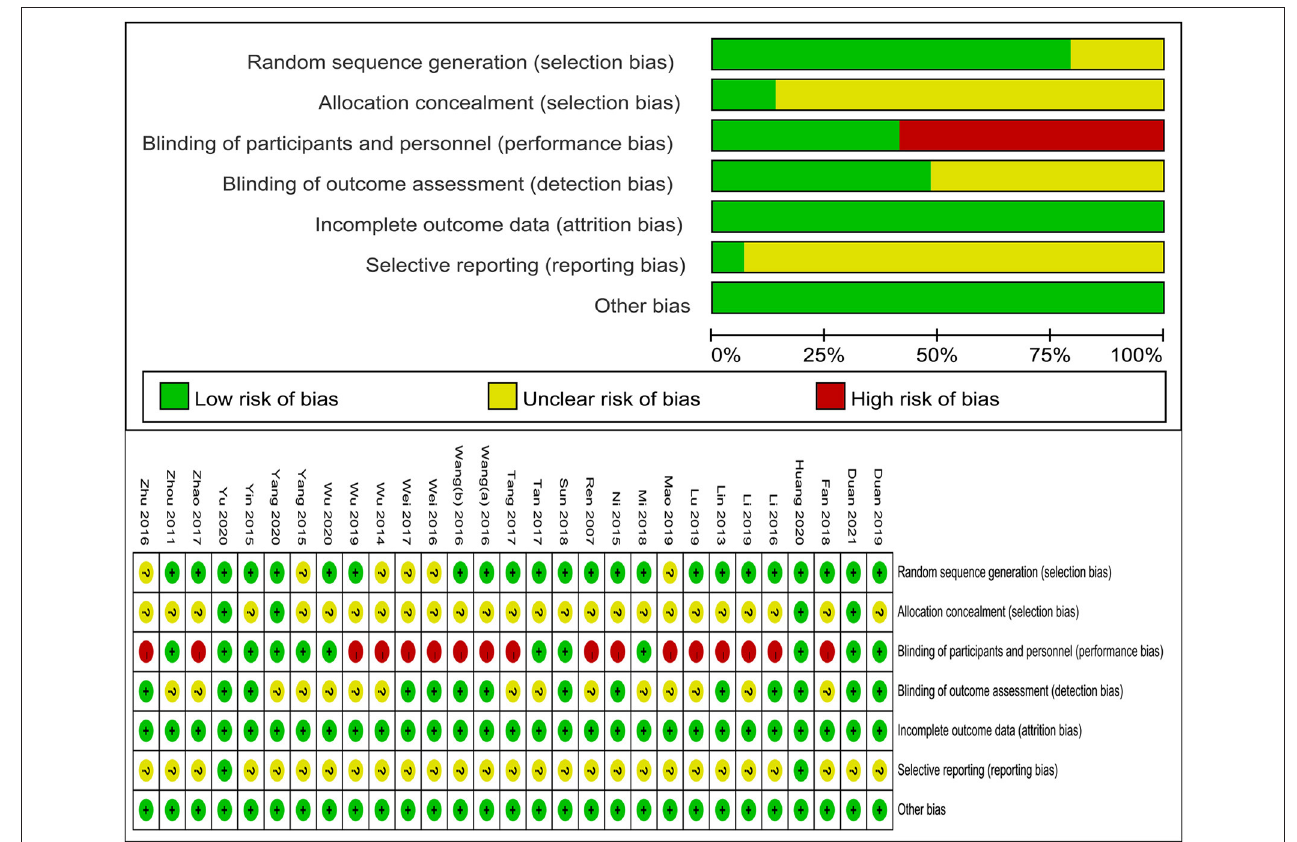
FIGURE 2 | Risk of bias